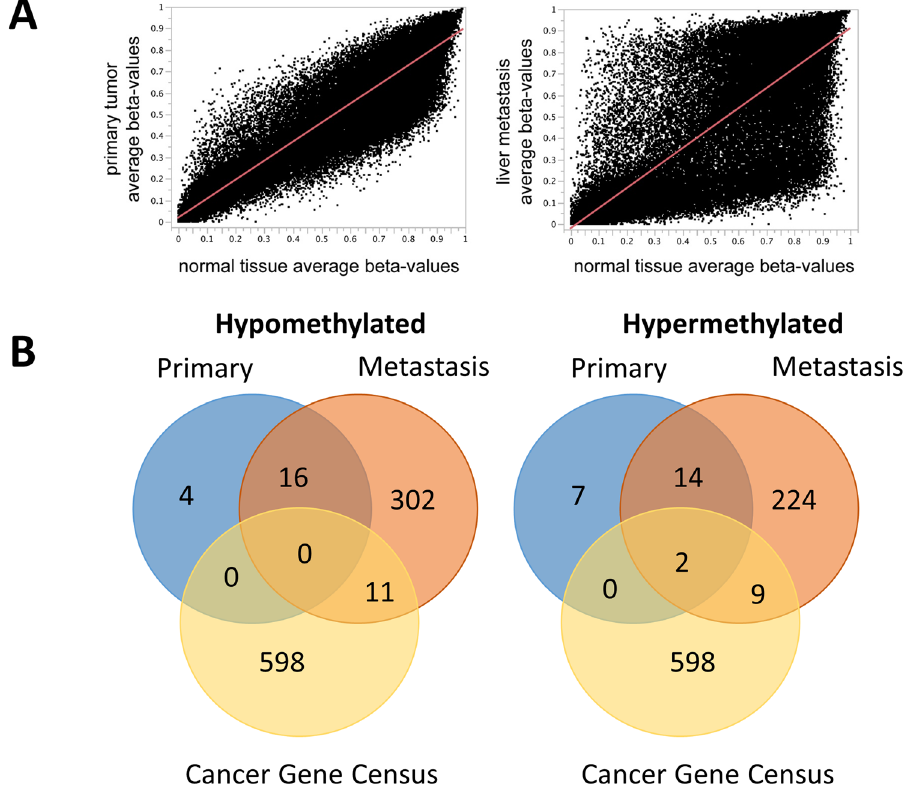
Figure 4. Methylation analsis of patient 1. ( A ) Average beta values of primary (left) and metastasis (right) in comparison to normal tissue of patient 1. 0 = fully unmethylated, 1 = fully methylated. ( B ) Comparison of genes harbouring promotor associated CpG sites with marked ( > 0.3 delta beta value) hypo- and hypermethylation in patient 1 and the COSMIC cancer gene